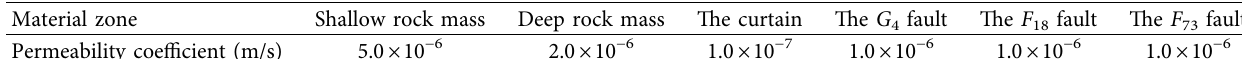
Table 3: Calculation results of the leakages through the F